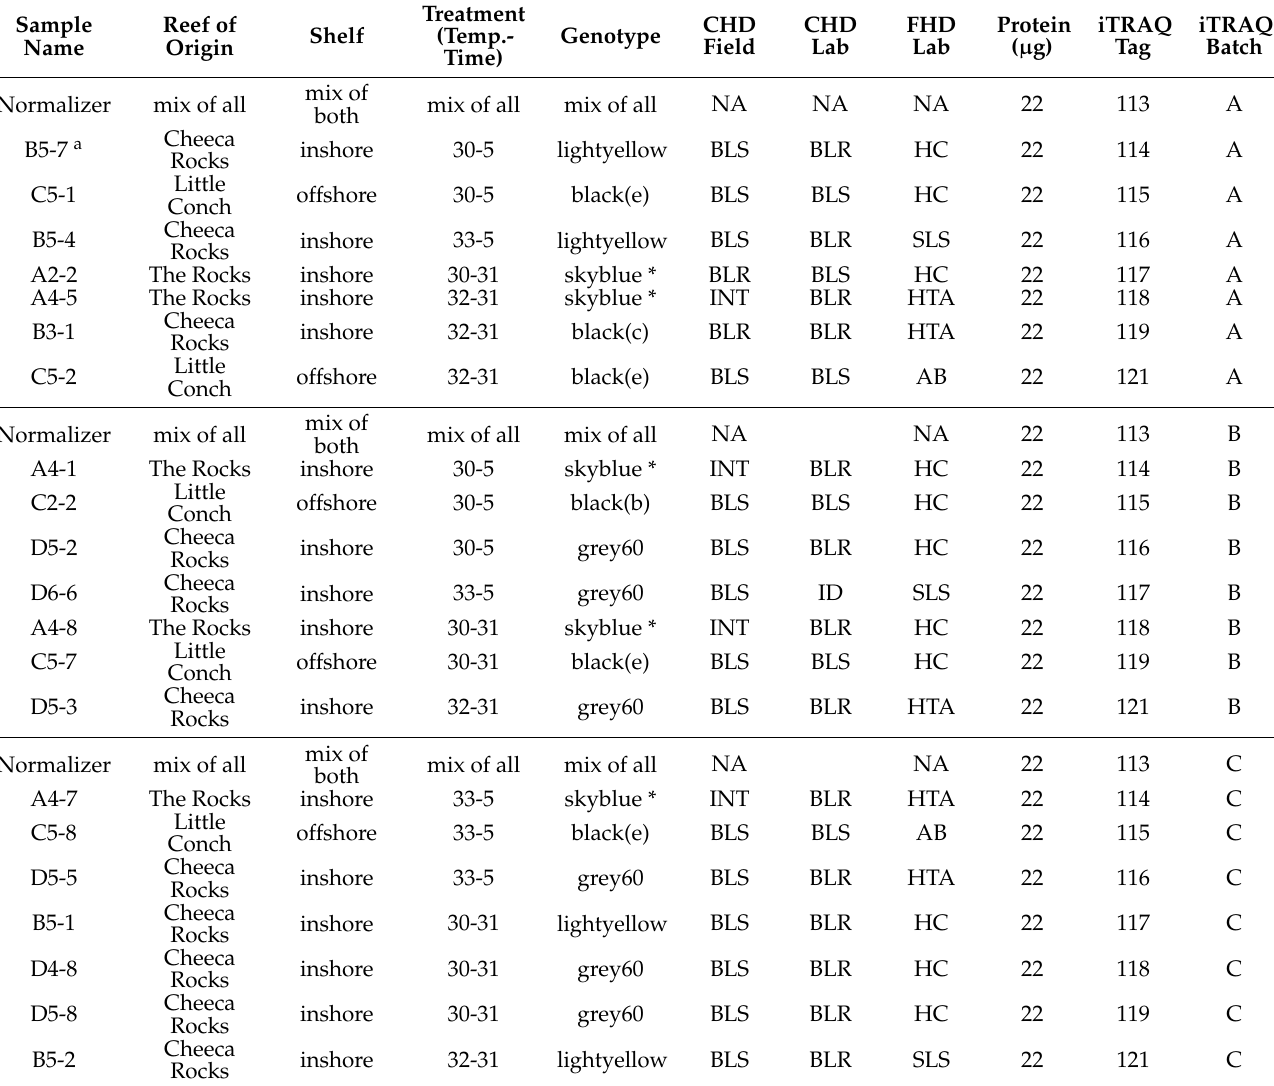
Table 1. Details of the 20 lab samples. This table bears similarity to Table 1 of [11] except that an additional colony health designation (CHD) column has been included for field samples. Note that the CHD was not always the same ex situ vs. in situ. Asterisks (*) denote genotypes whose field proteomes were assessed (Table 2). Abbreviations: AB = actively bleaching (n = 2). BLS = bleaching- susceptible, BLR = bleaching-resistant, INT = intermediate (field samples only), and FHD = fragment health designation. HC = healthy controls, HTA = high-temperature-acclimating (pooled with HC for most analyses), ID = indeterminant (not enough data to determine), NA = not applicable, and SLS = sub-lethally